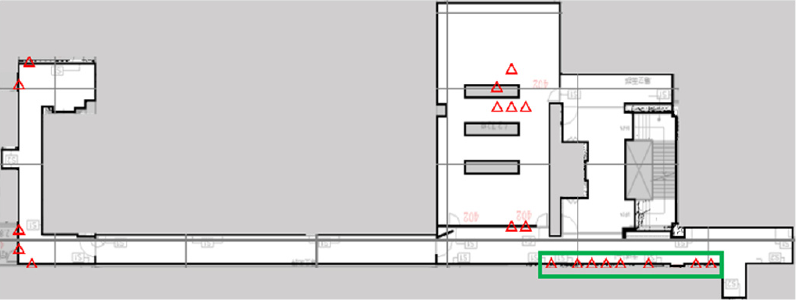
Figure 5. The optimal configuration Q that is calculated using the GA (20 Wi-Fi Sniffers). Before defining the entropy S for GA, it is important to use the concept of the covari- ance matrix for principal component analysis (PCA) to determine the correlation between Wi-Fi Sniffers [33,34]. An M × M covariance matrix Σ , for which each element represents the covariance between Sniffers, is defined as follows: